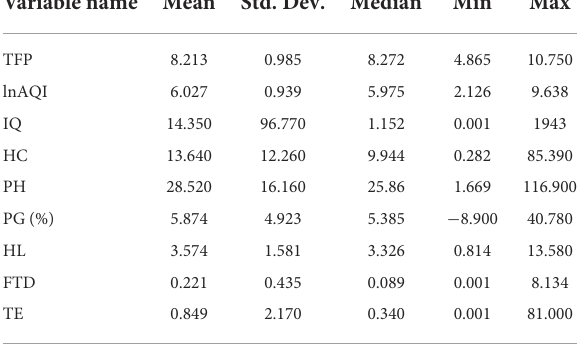
TABLE 1 Statistical description of